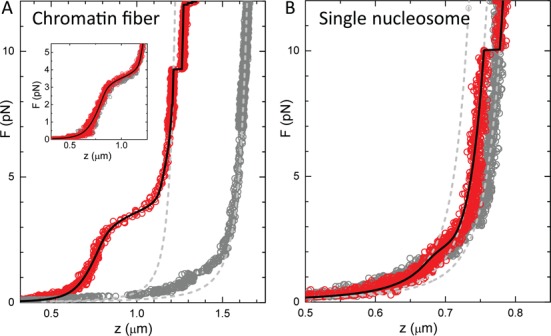
Comparison between force-extension curves of (A) a chromatin fiber and (B) a mononucleosome. Dark circles represent the pulling trace, light gray circles represent the release trace. All force-extension measurements are reversible, but a significant hysteresis is observed when the the force exceeds 6 pN. The inset in (A) shows a force-extension experiment in which the force was limited to 6 pN; no hysteresis is observed. Light gray dashed lines represent WLC descriptions of the bare DNA and the state in which all nucleosomes are in the extended conformation (see Figure 2). A third dashed line in (B) represents a WLC with a contour length 147 bp shorter than the bare DNA. Black lines are fits to Equation (8) yielding for (A) nfiber = 13, nunfolded = 4, k = 0.28 pN/nm, \documentclass[12pt]{minimal}
\usepackage{amsmath}
\usepackage{wasysym} 
\usepackage{amsfonts} 
\usepackage{amssymb} 
\usepackage{amsbsy}
\usepackage{upgreek}
\usepackage{mathrsfs}
\setlength{\oddsidemargin}{-69pt}
\begin{document}
}{}$z$\end{document}ext = 4.6 nm, ΔG1 = 20.6 kBT and ΔG2 = 5.5 kBT. For (B): \documentclass[12pt]{minimal}
\usepackage{amsmath}
\usepackage{wasysym} 
\usepackage{amsfonts} 
\usepackage{amssymb} 
\usepackage{amsbsy}
\usepackage{upgreek}
\usepackage{mathrsfs}
\setlength{\oddsidemargin}{-69pt}
\begin{document}
}{}$z$\end{document}ext = 6.5 nm, ΔG1 = 8.8 kBT and ΔG2 = 3.5 kBT.